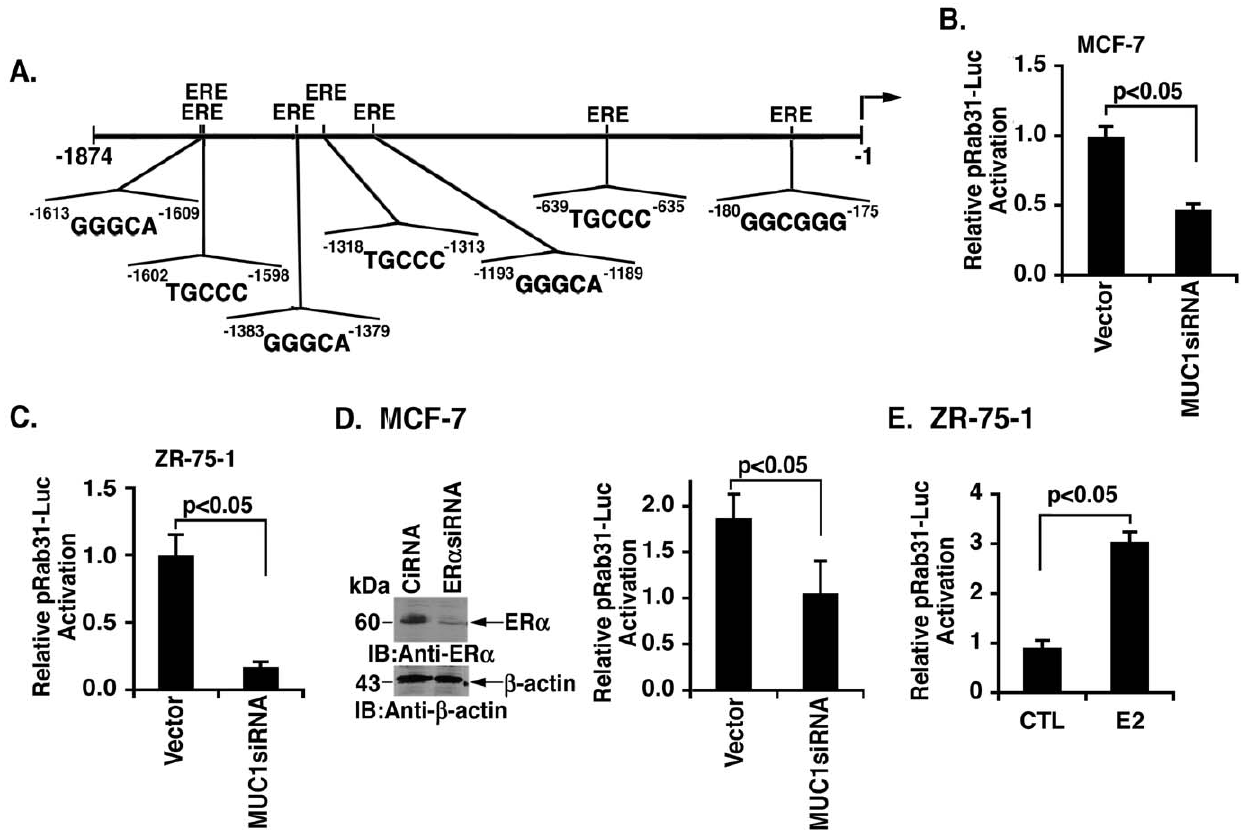
Figure 2. Activation of the Rab31 promoter by MUC1 and ER a . A. Schematic representation of the Rab31 promoter with localization of putative estrogen response elements (EREs). B and C. The indicated MCF-7 (B) and ZR-75-1 (C) cells were transfected with pRab31-Luc and Renilla plasmids for 48 h and then assayed for luciferase activity. The results are expressed as the relative luciferase activity (mean 6 SD of three determinations) compared to that obtained in the vector cells. D. MCF-7 cells were transiently transfected with control and ER a siRNA pools. Lysates were immunoblotted with the indicated antibodies (left). The cells were also transfected with pRab31-Luc and Renilla plasmids for 48 h. The results are expressed as the relative luciferase activity (mean 6 SD of three determinations) compared to that obtained in the CsiRNA-transfected cells (right). E. ZR-75-1 cells were transfected with pRab31-Luc and Renilla plasmids for 24 h. The cells were then cultured in phenol red-free medium with 2% charcoal dextran-treated serum for 72 h, treated with E2 for 24 h and assayed for luciferase activity. The results are expressed as the relative luciferase activity (mean 6 SD of three determinations) compared to that obtained in the untreated control (CTL) cells.